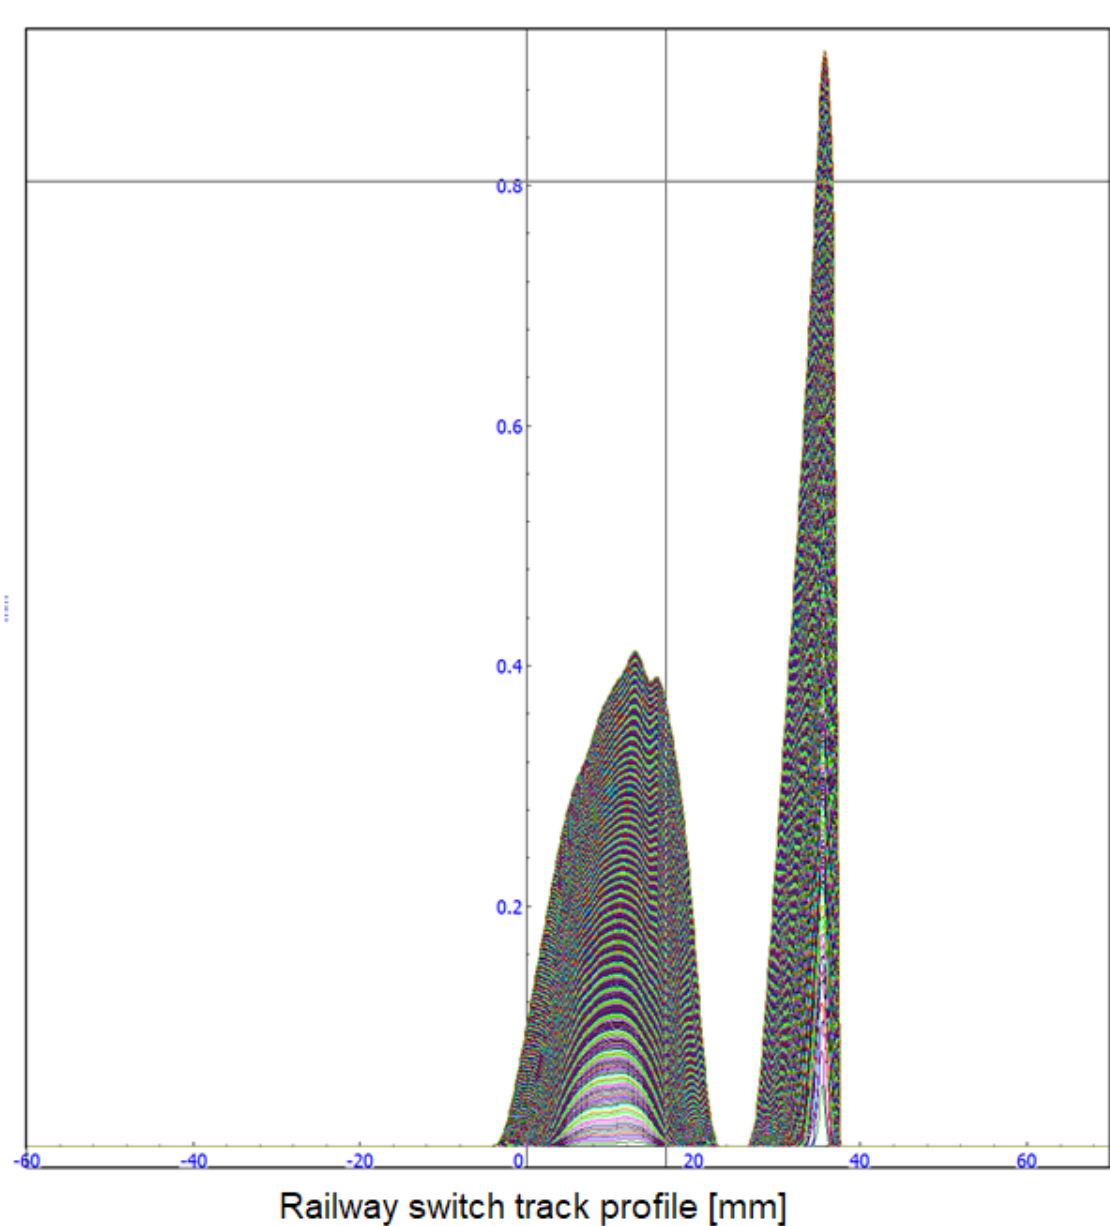
Figure 44. Rail wear at 300 km/h for straight-track traffic through a turnout.